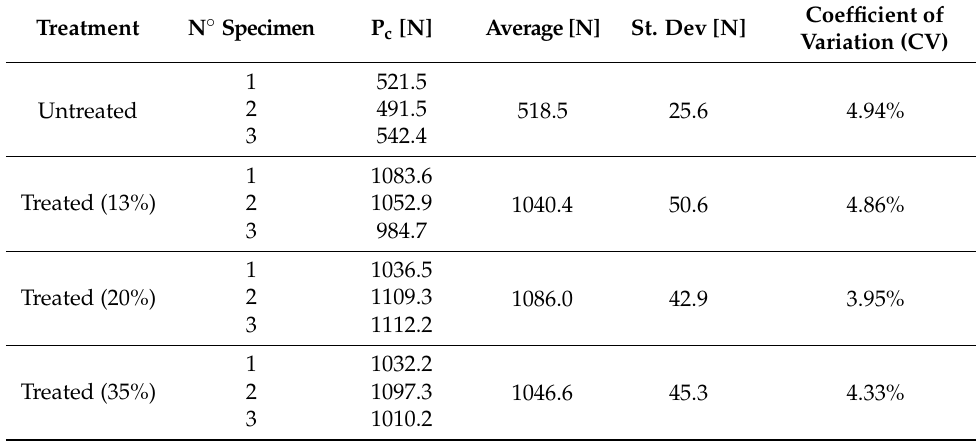
Table 5. Critical loads obtained from experimental tests.